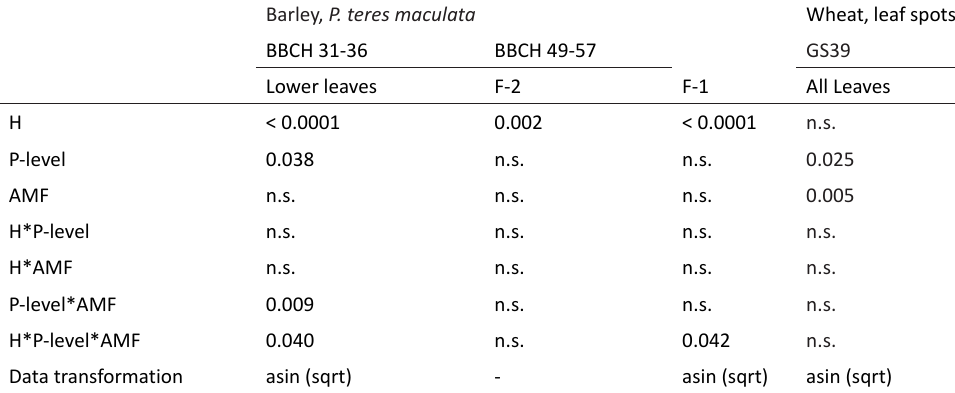
Table 6. Effects of hydrolysate treatment (H), P-level and AMF inoculation on disease severity of net blotch in spring barley and leaf spots in winter wheat in the pot experiment Barley, P. teres maculata Wheat, leaf spots